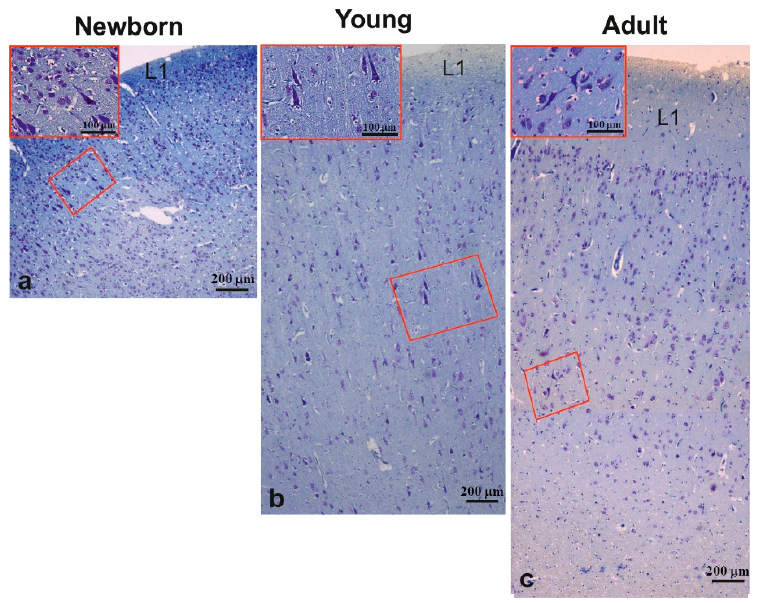
Figure 3. Nissl staining of the motor cortex of newborn ( a ), young ( b ), and adult ( c ) pigs. Insets of ( a – c ) show a high magnification of large pyramidal neurons in squared area of ( a – c ) pictures. L1, layer one.